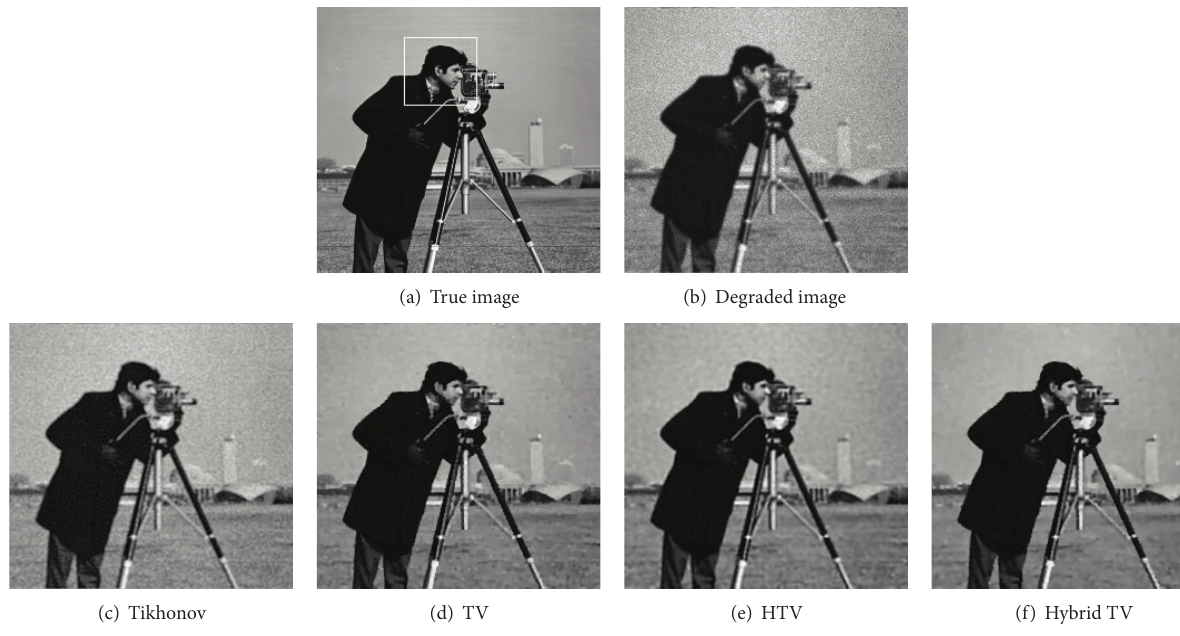
Figure 1: The “Cameraman” image is degraded by the Gaussian blur and Poisson